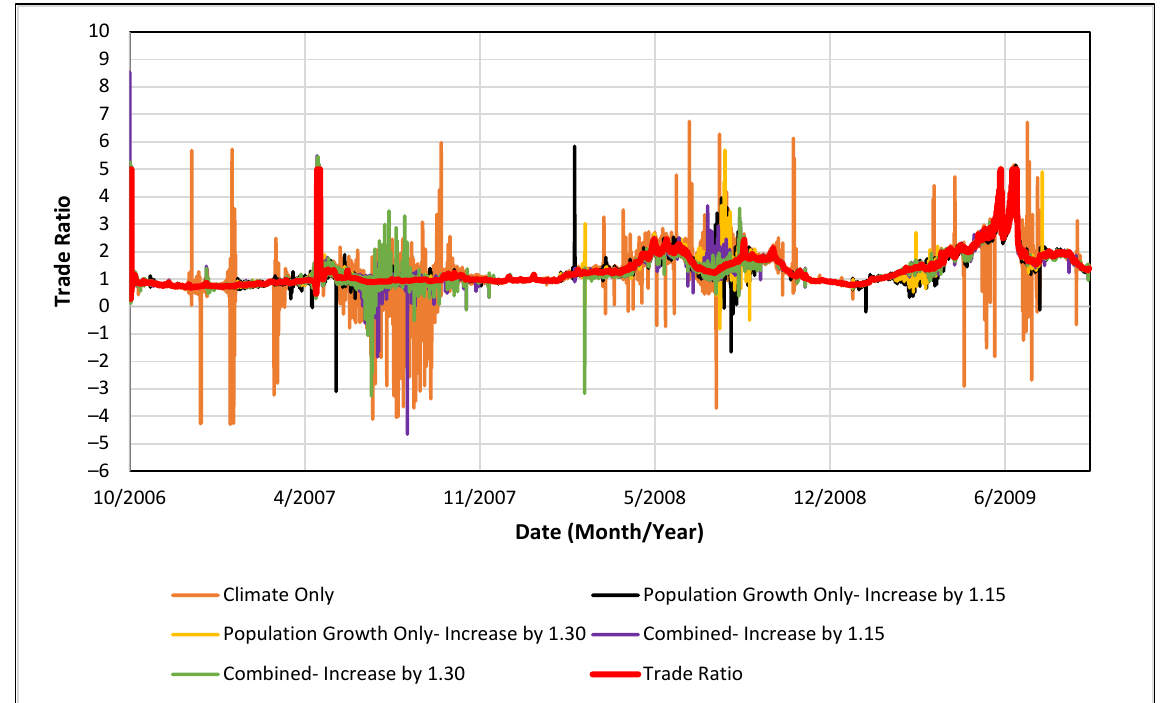
Figure 11. Composite Trade Ratio based on Sums for Delivery + Downstream Components with Equivalency Adjustments for Theoretical WQT Buyer TP Combined with Suggested Margins of Safety for Climate and Population Characteristics over the Jordan River Simulation Period (1 October 2006 to 30 September 2009) for RCP 8.5.